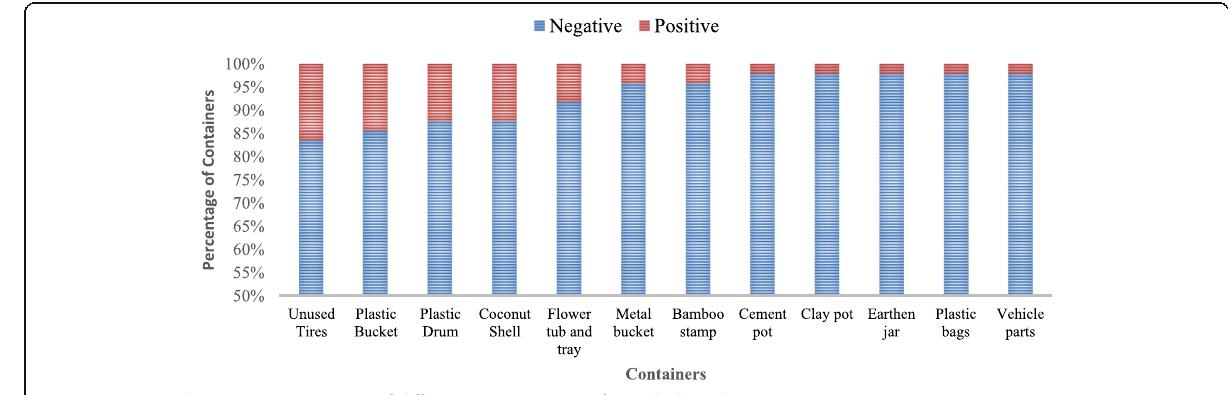
Fig. 3 Positive and negative percentages of different container types for Aedes